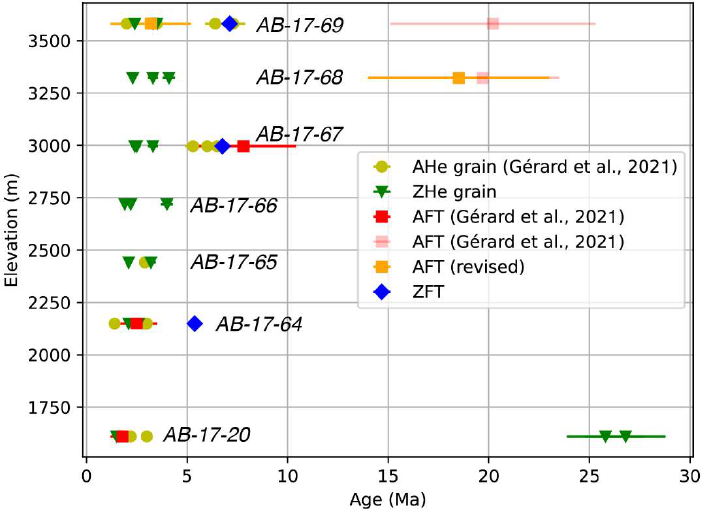
Figure 2. Age elevation of the Machu Picchu profile with AHe, ZHe, AFT, and ZFT data [20]; this study. The two upper AFT ages (pink squares) outside of the age-elevation trend were revised for this study.